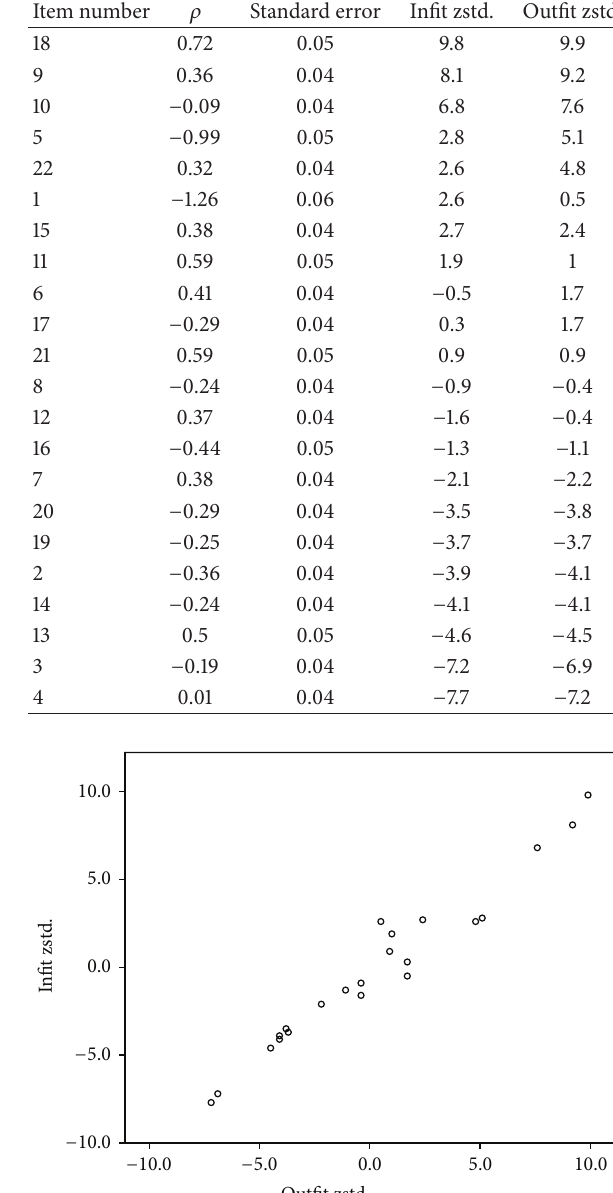
Table 3: Normalized item fit statistics.